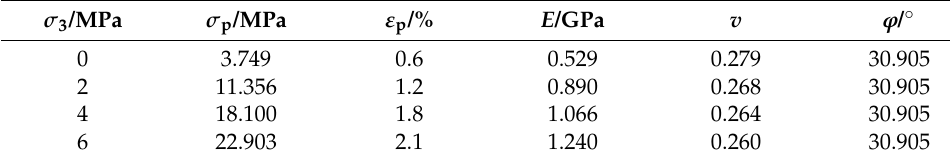
Table 4. Mechanical parameters of red sandstone under 20 freeze-thaw cycles.